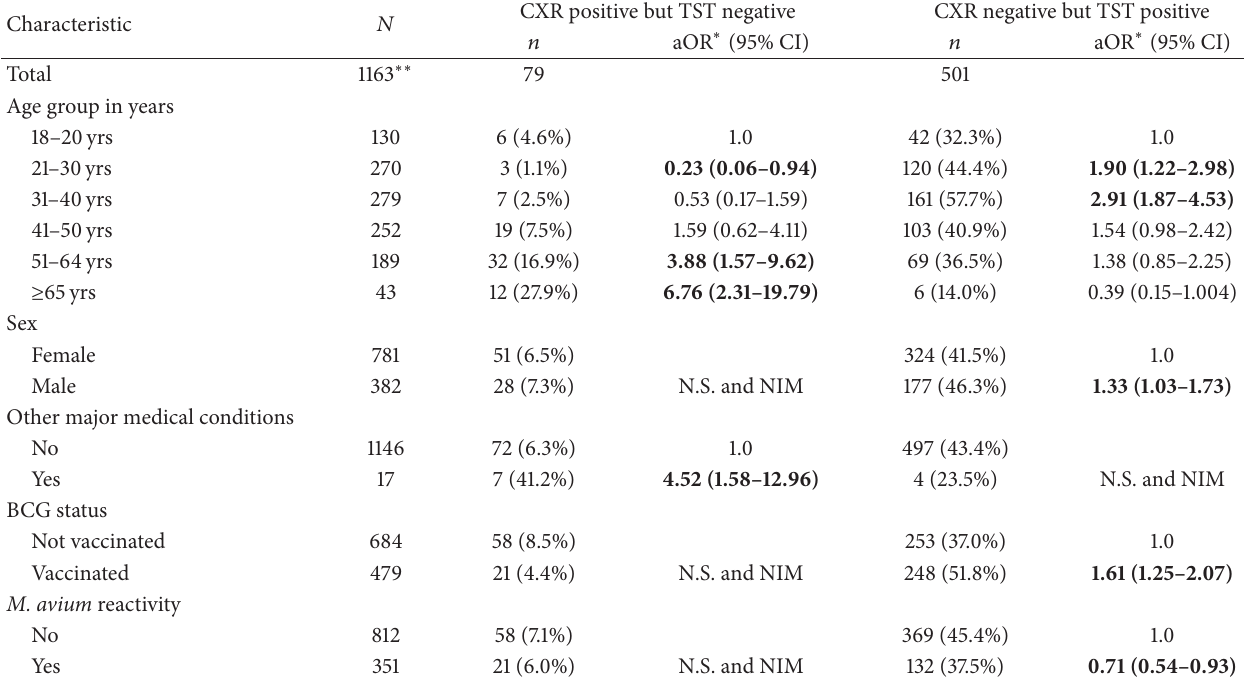
Table 6: Subject characteristics associated with CXR and TST